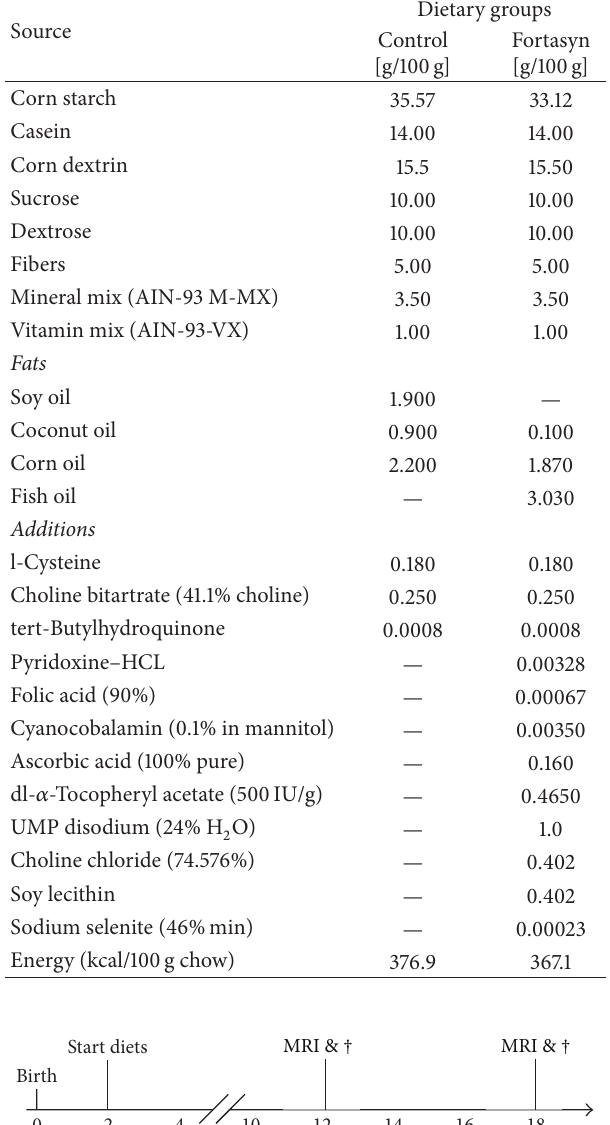
Table 1: Compositions of the experimental diets used, based on AIN-93M [37] with minor revisions.